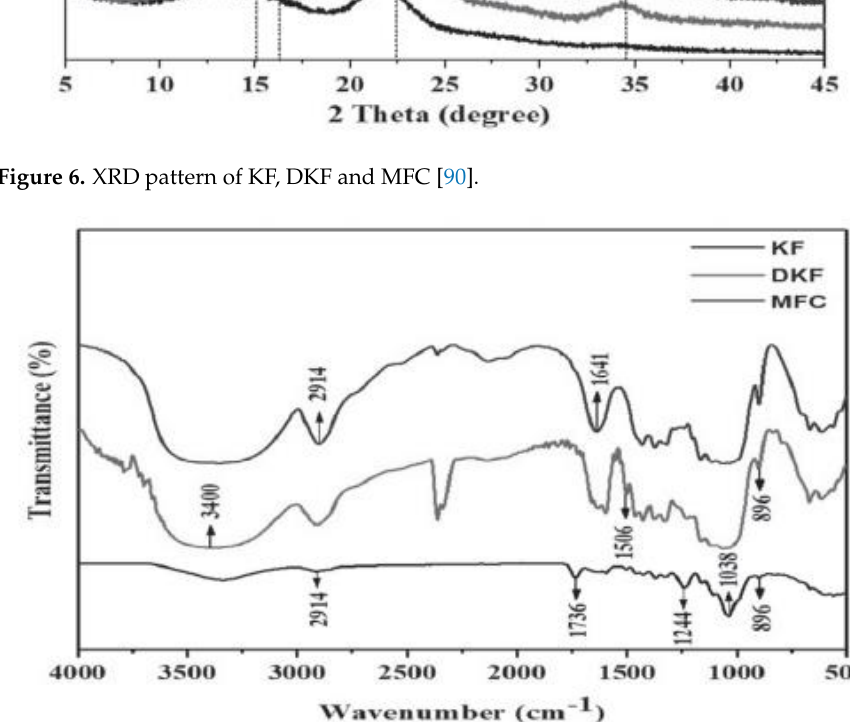
Figure 7. FT-IR spectra of KF, DKF and MFC [90].